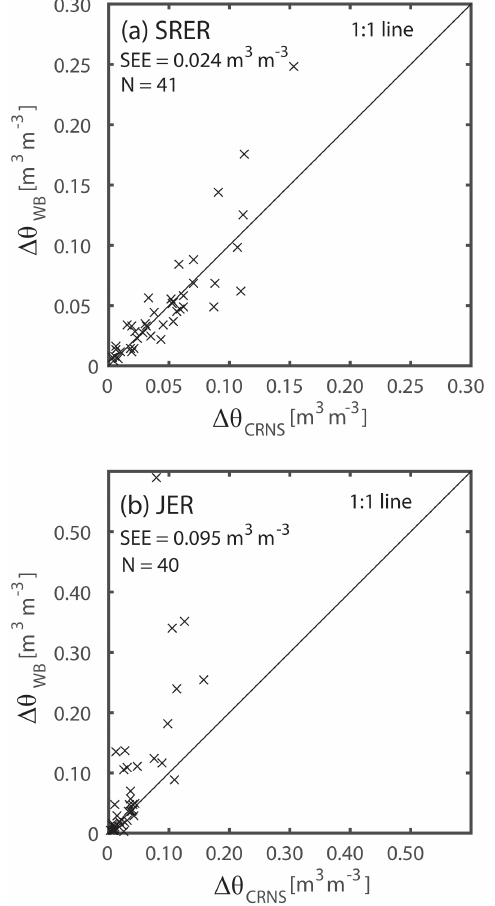
Figure 7. Scatter plots of the spatially averaged change in soil mois- ture (m 3 m − 3 ) derived from CRNS method ( (cid:49)θ CRNS ) and the ap- plication of the water balance ( (cid:49)θ WB ) at (a) SRER and (b) JER. The SEE and the number of event samples ( N ) are shown for each site.